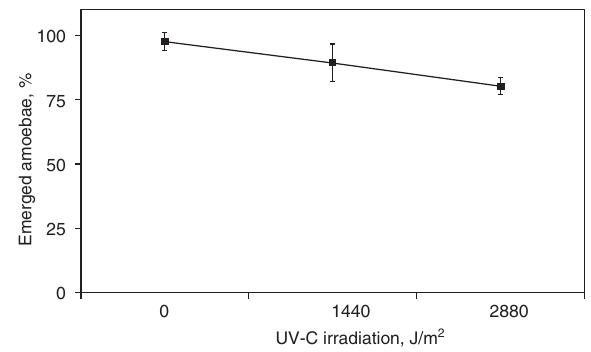
Figure 1 Germination activity of the spores in the UV-C-irradiated spore mass on the fruiting body. The spores were harvested from the UV-C-irradiated spore mass on the fruiting body and were then allowed to germinate in the reciprocal incubator after heat-shock treatment. Emerged amoebae and dormant spores were counted